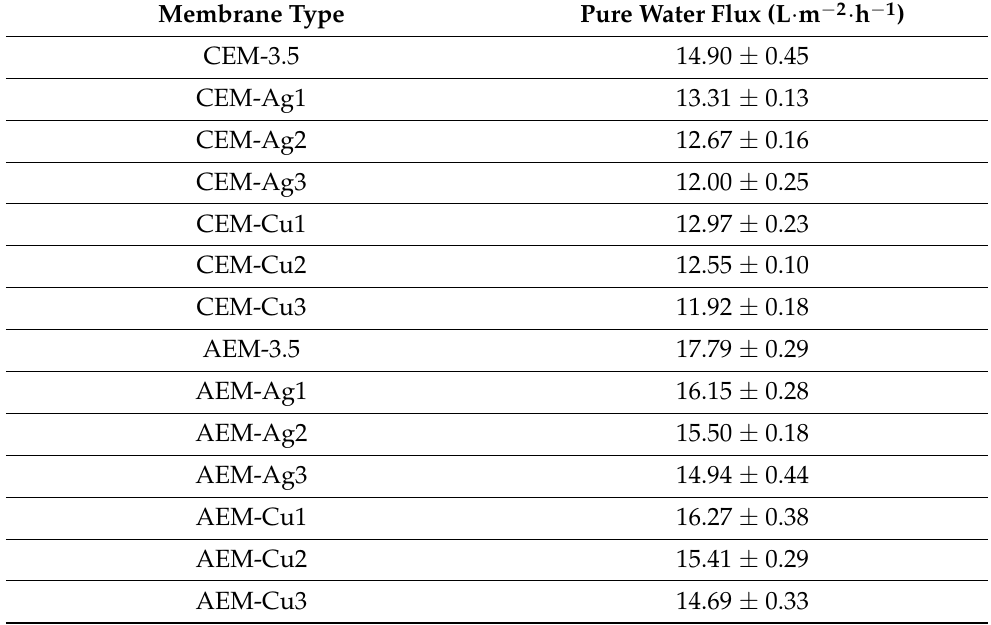
Table 7. Pure water flux of the Ag- and Cu-functionalized UF heterogeneous IEMs operated at 0.5 bars using the dead-end filtration